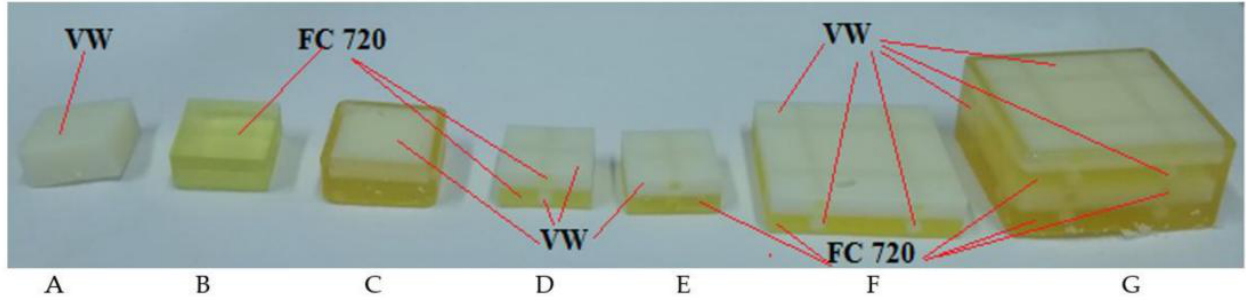
Figure 3. View of printed specimen models using a Connex printer, A–G samples